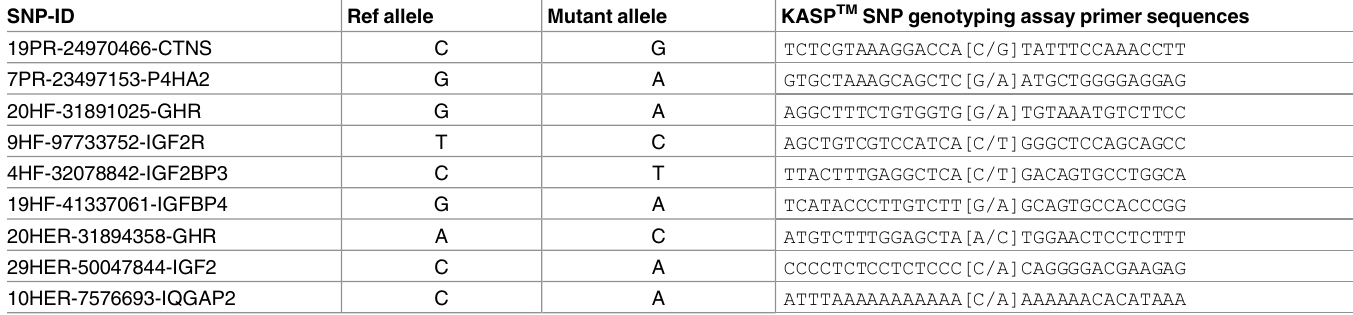
Table 7. SNP mutations and primer sequences of selected SNPs originating from the bovine liver RNA-seq experiment.